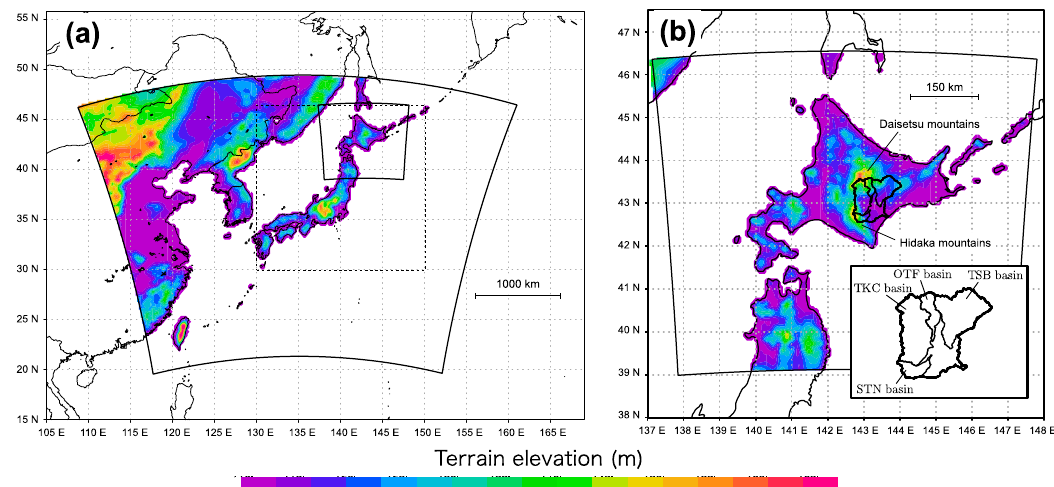
Figure 1. Simulation area and the target basins. ( a ) The outer solid line indicates the calculation area for d4PDF-DS20. The inner solid line indicates the simulation area for d4PDF-DS5. The dashed line indicates the TC-detection area. ( b ) The thick line indicates the entire Tokachi River basin. The inner solid lines indicate the area of the target sub-basins (TKC basin, OTF basin, STN basin, and TSB basin). The outer solid line indicates the simulation area for d4PDF-DS5. The colors represent the terrain elevation used in the dynamical downscaling.